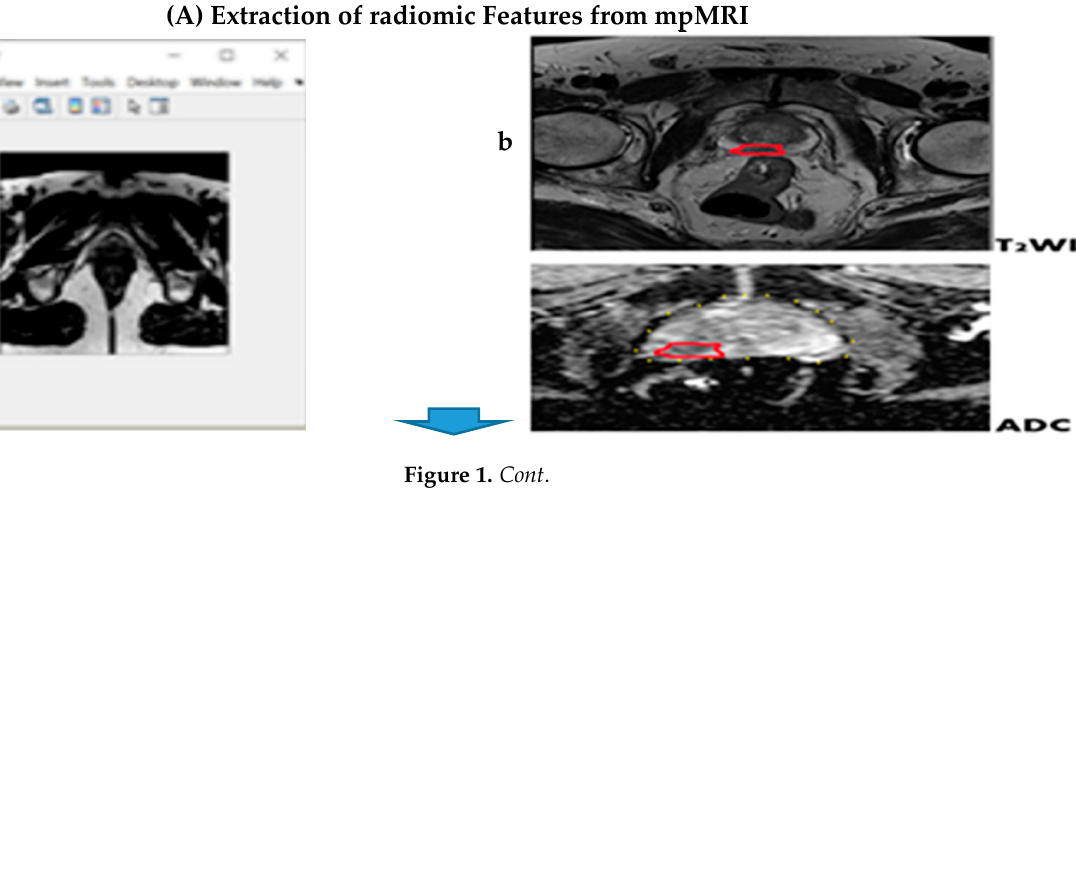
Table 1. Demographic data and Gleason grouping.